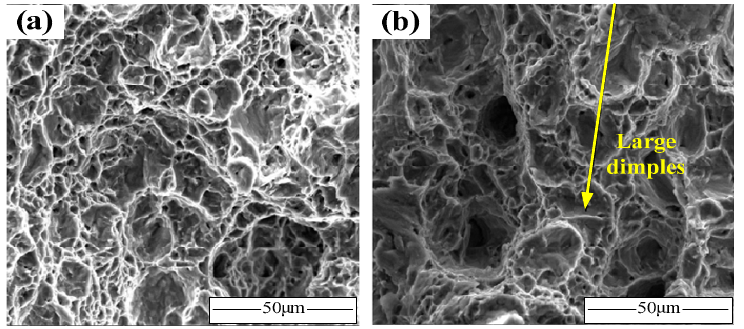
Figure 9. SEM micro-morphology of fracture surface ( a ) 0.01 s − 1 , 2 °C and ( b ) 1500 s − 1 , 25 °C [79]. Reprinted with permission from Ref. [79]. Copyright 2016, J. Alloy. Compd.